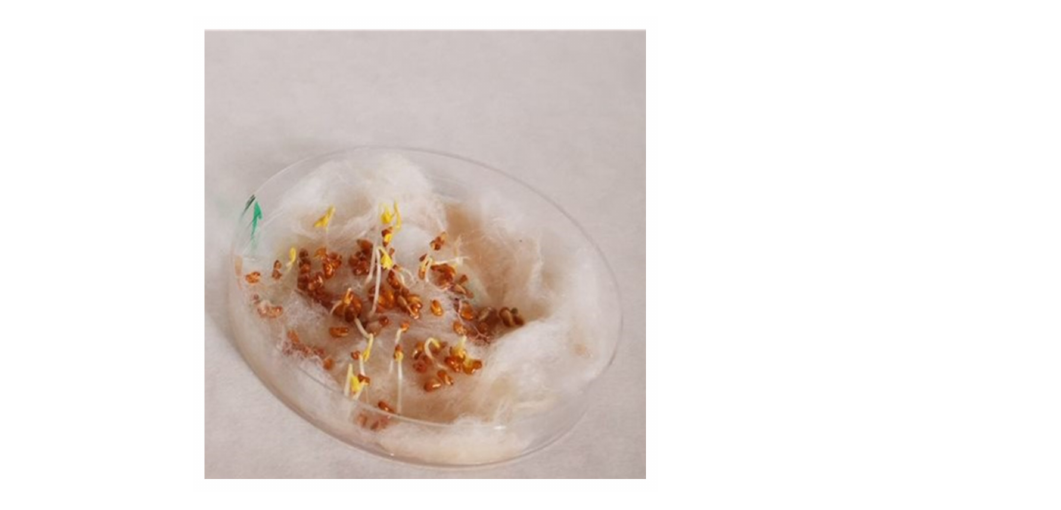
Figure 1. Photos of germination and growth of cress ( Lepidium sativum L.) seeds with double- layered films.